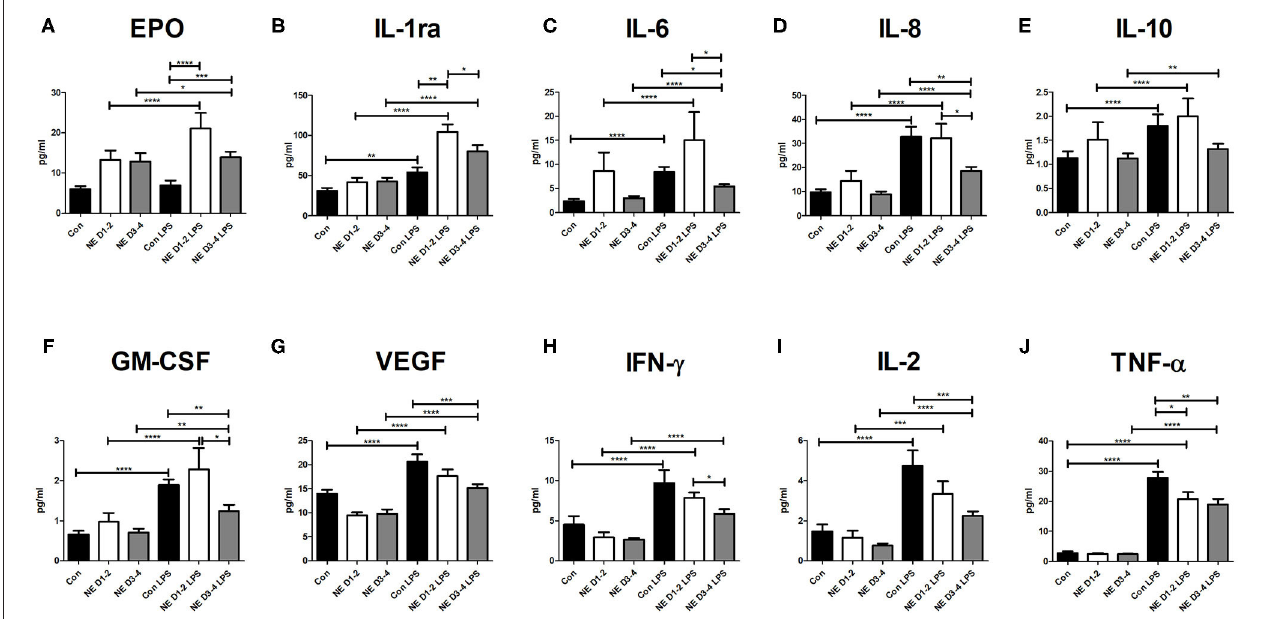
FIGURE 2 | Cytokine levels in NE and control after LPS stimulation. Whole blood sampling was performed in the 1st week of life, samples were stimulated with 1 µ g/ml of LPS, and a 14-spot ELISA Multiplex Cytokine Array was performed. Graphs represent pg/ml of each cytokine measured in samples of control, NE days 1–2, and NE days 3–4. Cytokines measured are (A) Epo, (B) IL-1ra, (C) IL-6, (D) IL-8, (E) IL-10, (F) GM-CSF, (G) VEGF, (H) IFN- γ , (I) IL-2, and (J) TNF- α . p* = p < 0.05, p** = p < 0.01, p*** = p < 0.001, p**** = p < 0.0001. NE, neonatal encephalopathy; LPS, lipopolysaccharide; Epo, erythropoietin; IL, interleukin; GM-CSF, granulocyte-macrophage colony-stimulating factor; VEGF, vascular endothelial growth factor; IFN, interferon; TNF, tumor necrosis